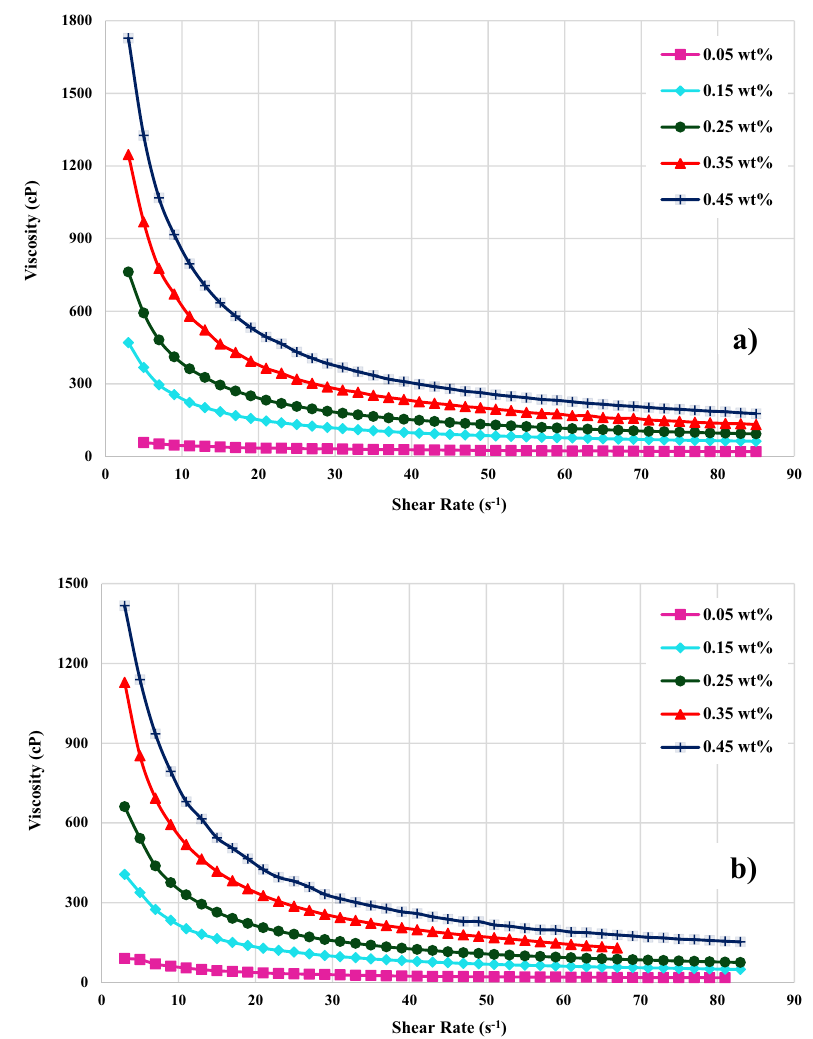
Figure 3: Dependence of the viscosity of polymer on the shear rate: ( a ) T = 25°C and ( b ) T =